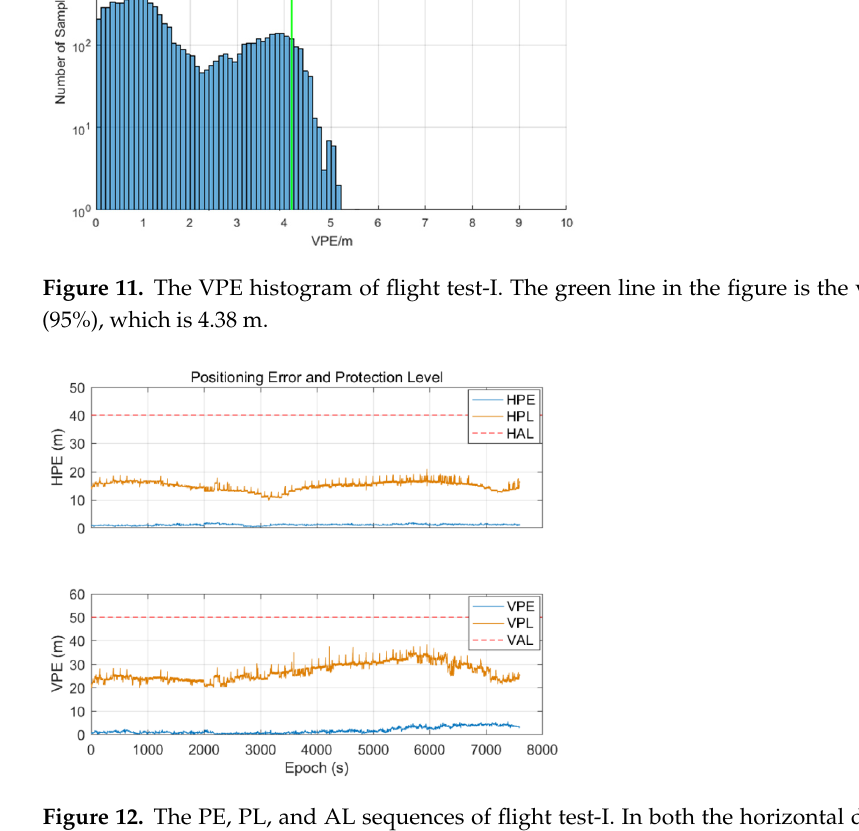
Figure 12. The PE, PL, and AL sequences of flight test-I. In both the horizontal direction (see the top panel) and the vertical direction (see the bottom panel), the PL can completely cover the PE and neither exceeds the PL, which means that no false alarms or missed alarms occurred during the test.